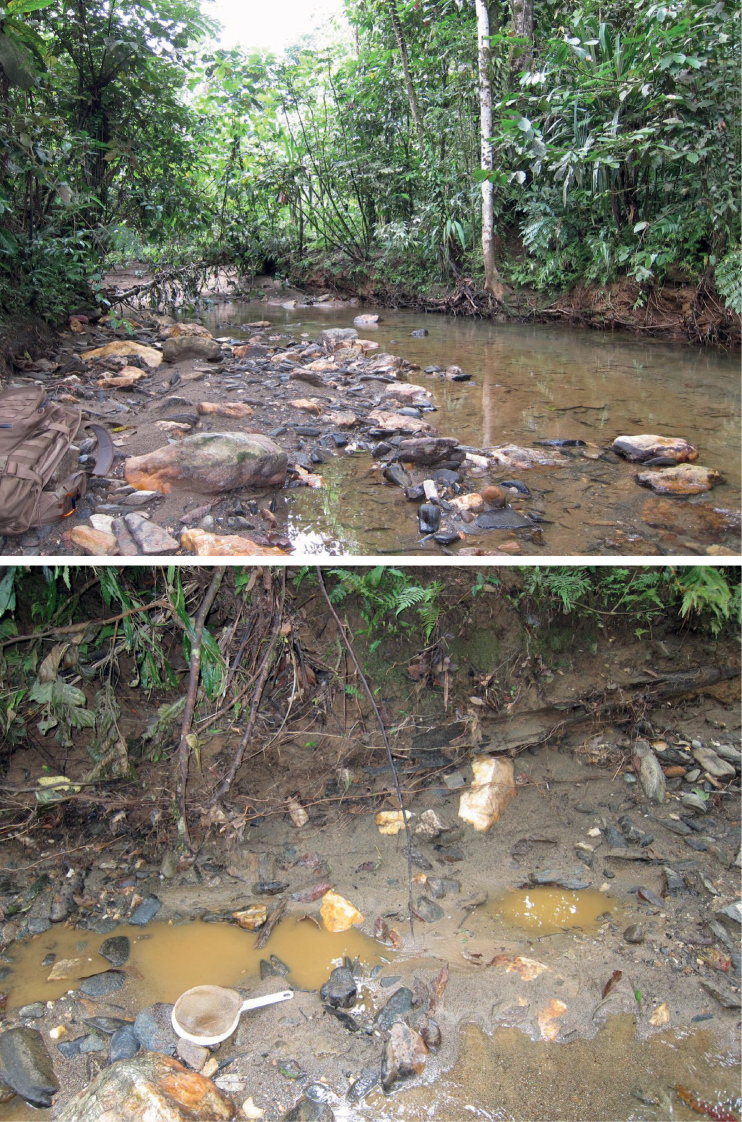
Habitat of Exocelina utowaensis sp. n. and Exocelina pseudosoppi sp. n.: Indonesia, Papua Province, Nabire-Enarotali Road, 62nd km, stream in the flat stretch of the lowland forest.